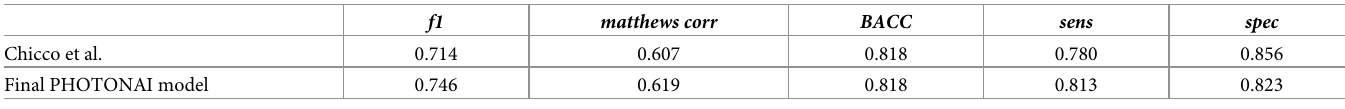
Table 3. Test performance metrics for the final